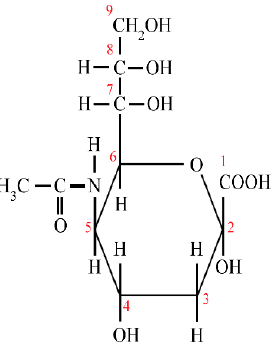
Figure 1. The structure of sialic acid. 1–9 — the number of carbon